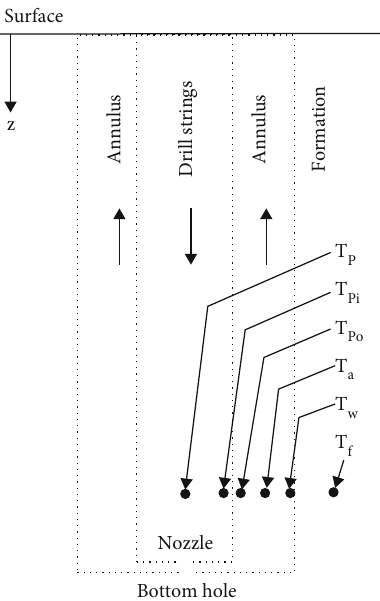
Figure 1: The circulation of the gas drilling system.